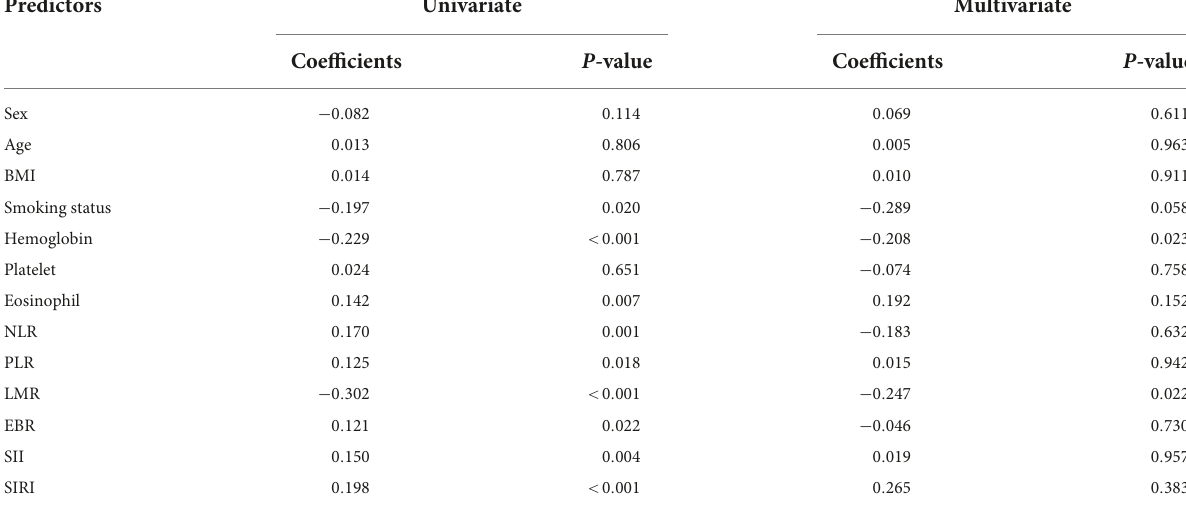
TABLE 4 Univariate and multivariate correlation between symptom severity and inflammatory